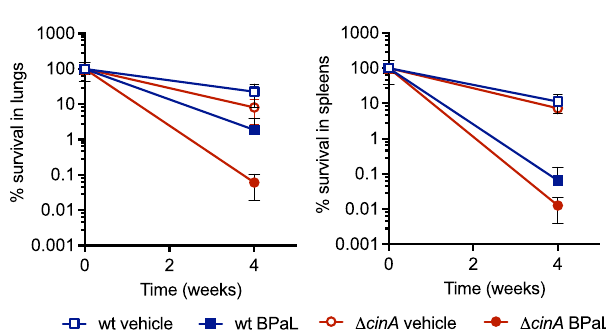
Fig. 6 Deletion of cinA potentiates the ef fi cacy of BPaL. Balb/C mice were infected with wild-type and Δ cinA and treated with BPaL (bedaquiline 20 mg/kg/day, pretomanid 50 mg/kg/day, and linezolid 100 mg/kg/day) starting after 4 weeks of infection. CFU recovered from lungs and spleens are normalized to the beginning of BPaL treatment. Data are means ± SD of six mice. Source data are provided as a Source Data fi